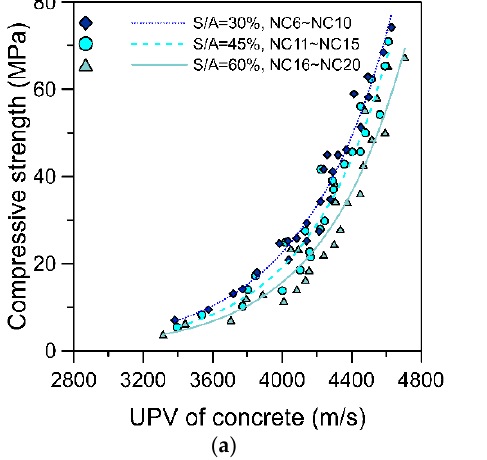
Figure 4. Relationship between the UPV and strength of normal concrete specimens with various coarse–fine aggregate mixture proportions: ( a ) UPV and strength, ( b ) UPV and strength evolution index.